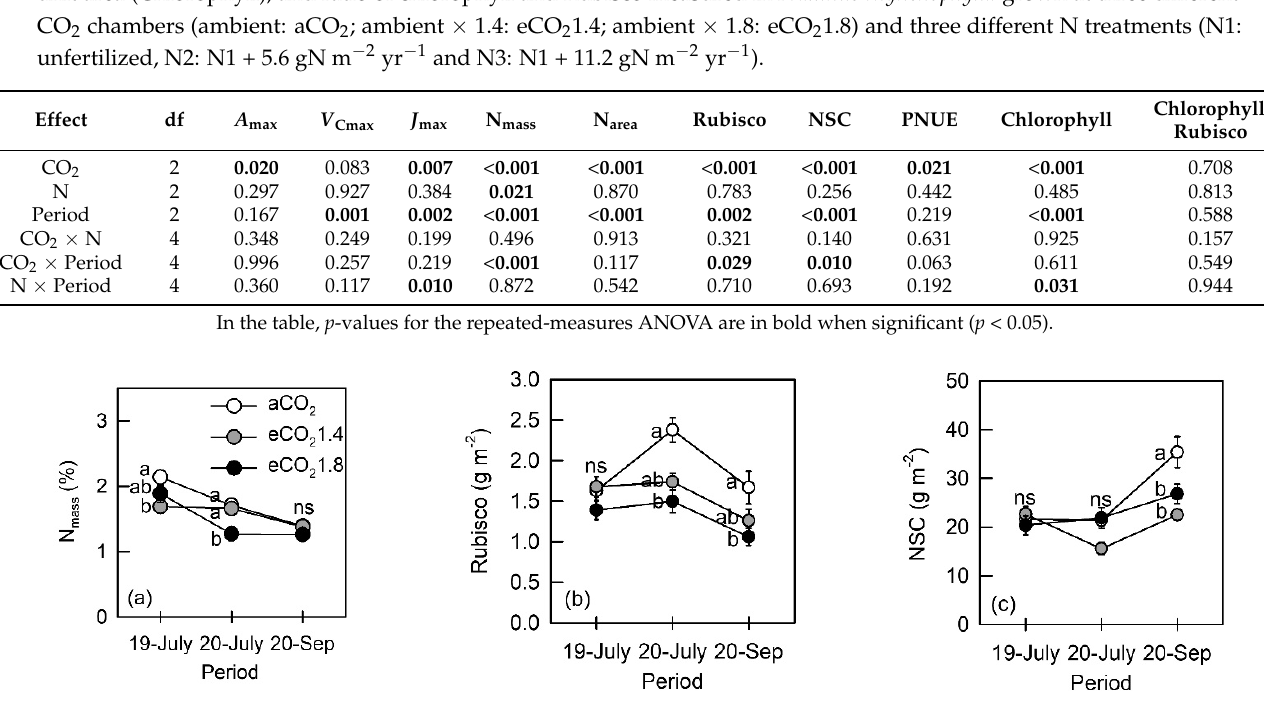
Figure 2. The average of ( a ) nitrogen per unit mass (N mass ) ( b ) Rubisco per unit area (Rubisco) and ( c ) nonstructural carbohydrates per unit area (NSC) measured in Fraxinus rhynchophylla grown in three different CO 2 chambers (ambient: aCO 2 ; ambient × 1.4: eCO 2 1.4; ambient × 1.8: eCO 2 1.8) for three periods. Results are presented as mean + SE in each CO 2 treatment: aCO 2 (white circle), eCO 2 1.4 (grey circle) and eCO 2 1.8 (black circle). The X axis represents period (19-July: July 2019, 20-July: July 2020 and 20-Sep: September 2020). There were interactions between CO 2 × Period. Different letters indicate significant differences among CO 2 treatments in each period and ns indicate non-significant (Tukey’s test, p <